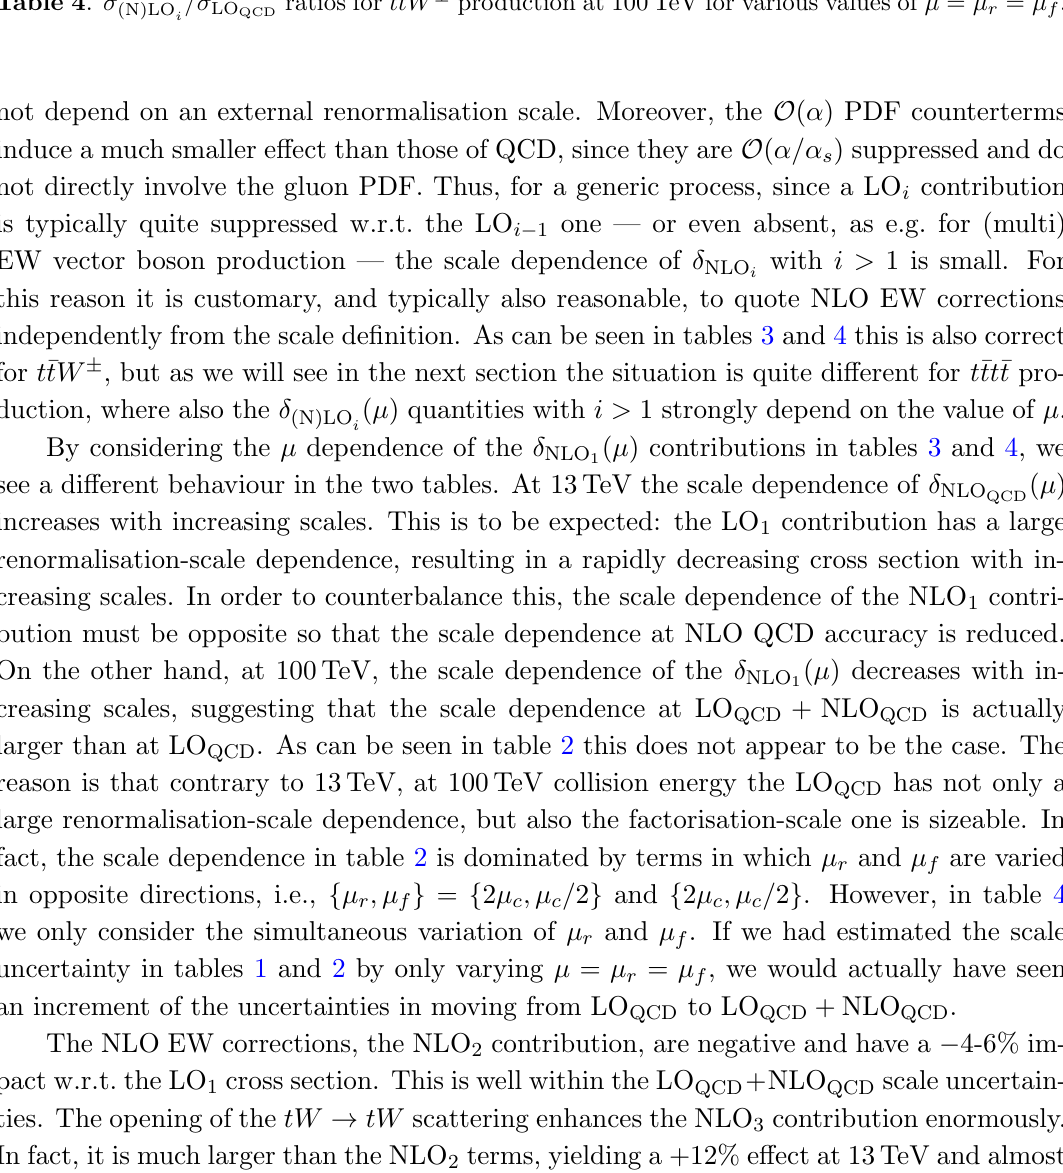
) suppressed and s